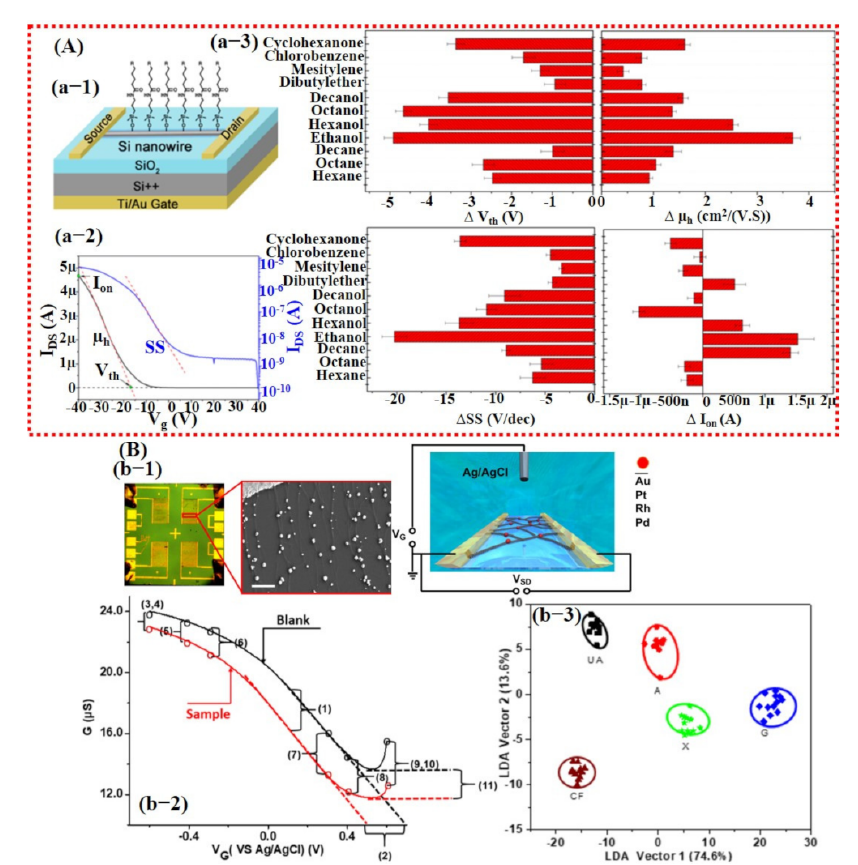
Figure 17. Smart gas sensing using FET-based devices and machine learning. ( A ) Modified single Si NW-based FET device for VOCs detection: (a-1) Schematic diagram of the fabricated FET device. (a-2) Typical IDS response curve of FET device labeled with the extracted features (V th ), ion, hole mobility, and SS for data processing. (a-3) Variations in (a) V th , (b) µ h , (c) SS, and (d) ion of sensor S4 upon exposure to various VOCs at a concentration of pa/po = 0.08. Reproduced with permission from [137], copyright 2014 ACS. ( B ) Metal catalyst decorated on the CNT-based FET device for detection of purine compounds: (b-1) Optical and schematic images of the fabricated device. The inset reveals the SEM image of CNTs decorated with NPs. (b-2) Pt NP-decorated NTFET response with and without caffeine (1 mM) solutions. Selected features (11) were calculated from the NTFET curves before and after exposure of caffeine solutions. (b-3) LDA plots for purine compound discrimination. Reproduced with permission from [139], copyright 2019